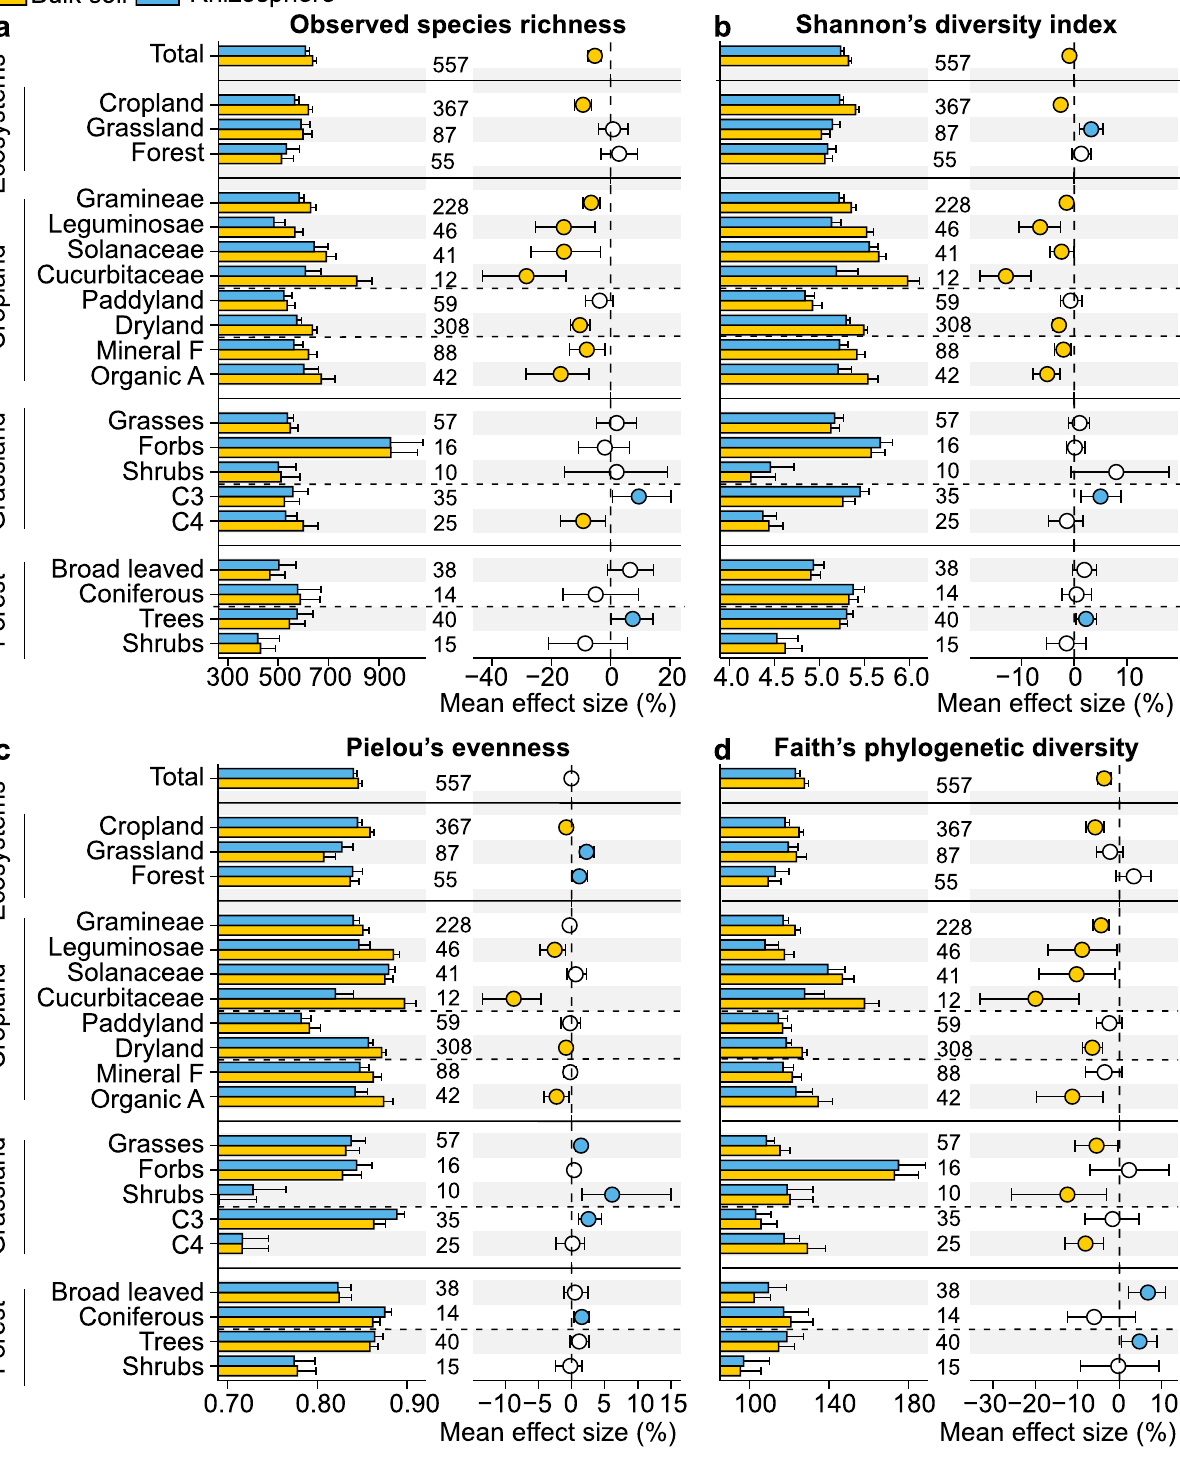
Fig. 1 Diversity of bacterial communities: the rhizosphere versus bulk soil. a observed species richness; b Shannon ’ s diversity index; c Pielou ’ s evenness; and d Faith ’ s phylogenetic diversity. Bar charts re fl ect mean value and standard errors for each category. The error bars on the columns represent the standard errors (SE). All dots represent the percentage change in effect size between rhizosphere and bulk soil bacterial diversity at 95% con fi dence intervals (CIs). Mean values <0 indicate greater diversity in the bulk soil bacterial community (yellow dots; depletion in the rhizosphere), while mean values >0 re fl ect signi fi cantly greater diversity in the rhizosphere bacterial community (blue dots). The intersection of the error bars and the zero line indicates that there is no signi fi cant difference between the bacterial communities in the rhizosphere and in the bulk soils (open dots). Sample size is showed by number of data pairs for each group. Mineral F and Organic A indicate the types of fertilization, which are mineral-only fertilization and organic amendments, respectively. Source data are provided as a Source Data fi le.